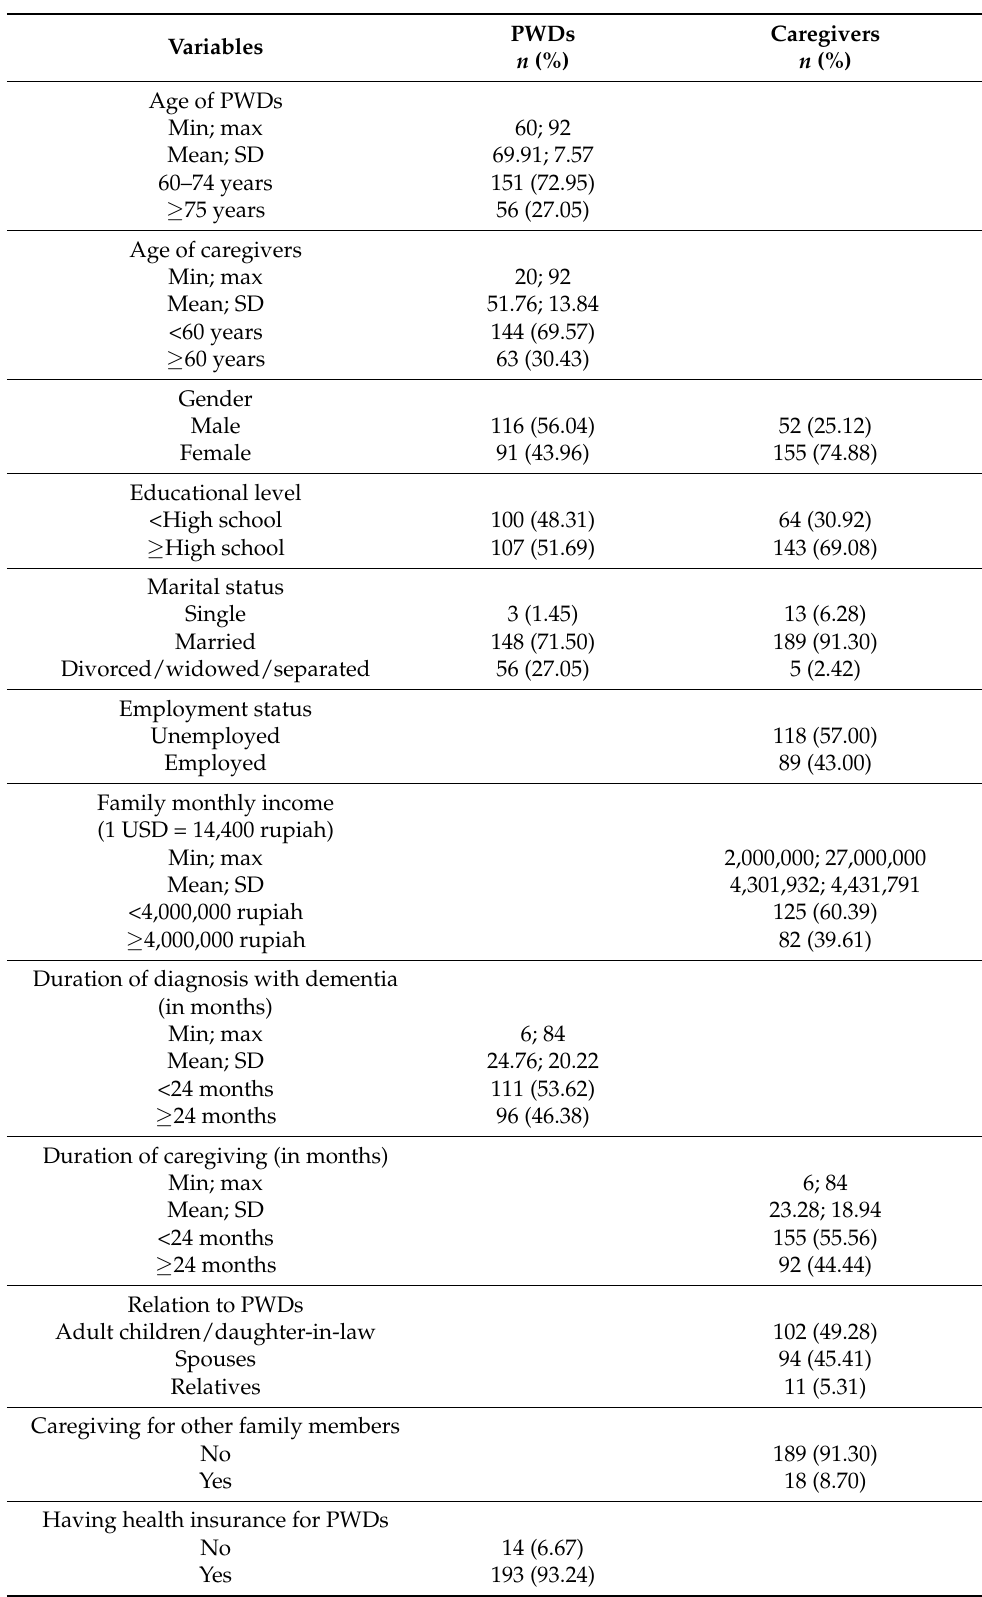
Table 1. Characteristics of PWDs and caregivers ( n =